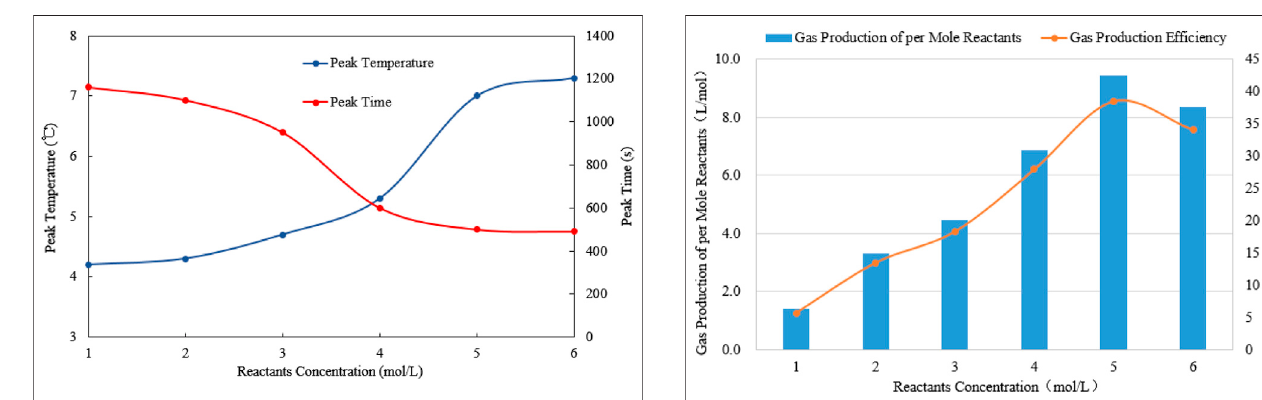
FIGURE 12 | Relationships of the reactant concentration with gas production of per mole reactants and with gas production ef fi